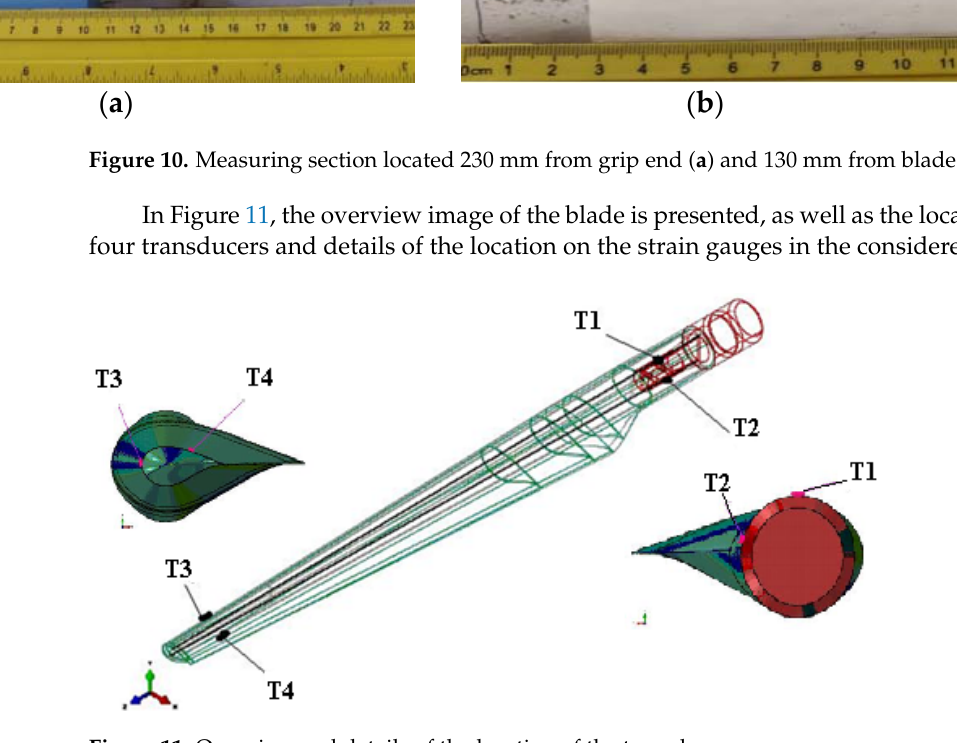
Figure 11. Overview and details of the location of the transducers.